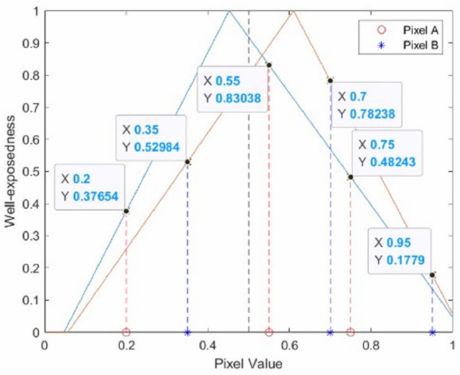
Figure 5. Exposure rates of Pixel A and B in this paper.